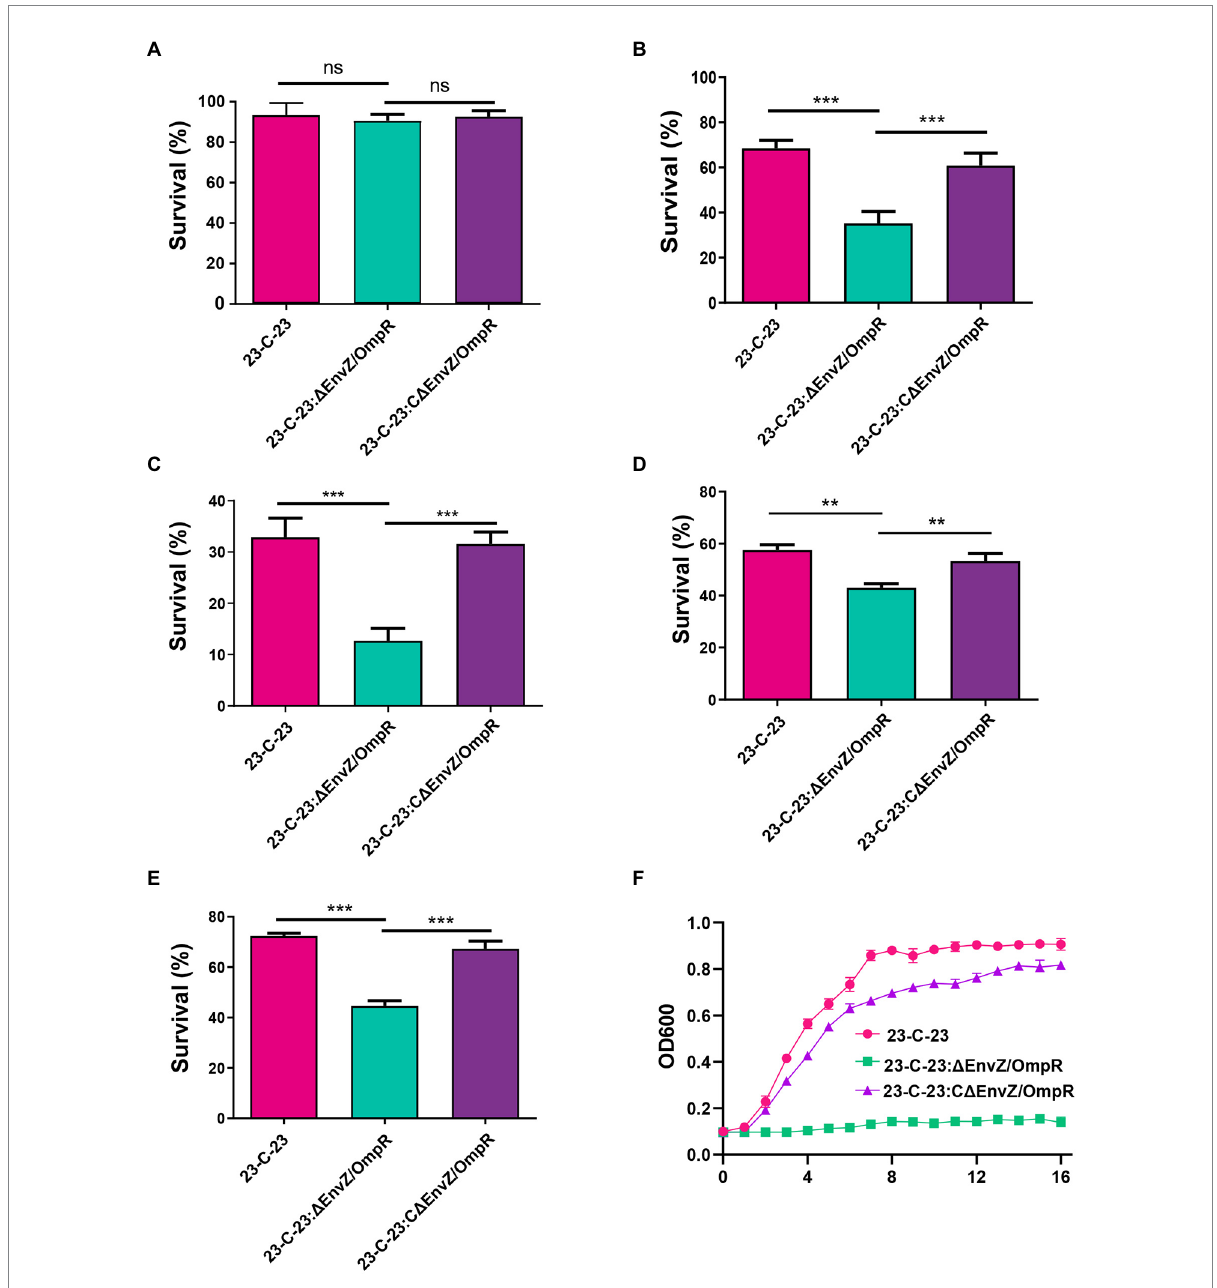
FIGURE 4 Effects of EnvZ/OmpR on the viability of 23-C-23 under different stress conditions. (A,B) Temperature stress assay. The strains were cultured to log-phase. The culture was adjusted with TSB liquid medium to an OD 600 of 0.1, then the bacterial suspension incubation at 28 (as a control), 37, and 42 ° C for 24 h. Then the cultures were double-diluted with sterile PBS and coated onto TSA plates. (A) 37 ° C, (B) 42 ° C. (C,D) Acid and alkali tolerance. The strains were cultured to log-phase. Bacteria were treated for 30 min in TSB at different PH (pH 5.0, pH 7.0, and pH 9.0). Next, viable cells were plated on TSA plates after dilution. The ratio of CFUs in treatment group to that control group was calculated to assess the percent survival. (C) pH 5.0, (D) pH 9.0. (E) Oxidative stress assay. The strains were cultured to log-phase. Bacteria were treated for 20 min in PBS with 0.1 M H 2 O 2 , and without H 2 O 2 as a control. Viable cells were counted on TSA agar plates. The ratio of CFUs in treatment group to control group was calculated to assess the percent survival. (F) Osmotic stress assay. The cells were collected, and resuspended in fresh TSB with 0.5 M NaCl to an OD 600 of 0.1. The OD 600 of each culture was real time monitored every 1 h for 16 h to detect the growth. Values are expressed as the mean ± SD of three individual experiments. ** p < 0.01, and *** p < 0.001.